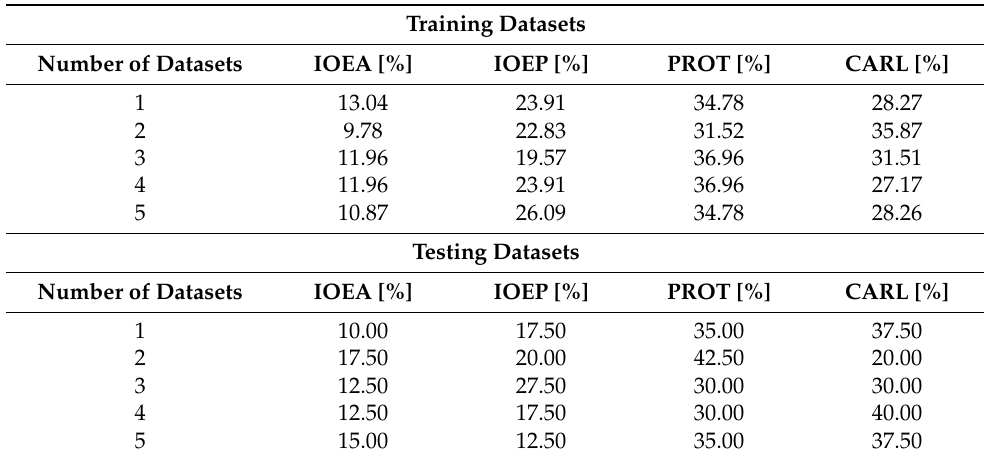
Table 2. Percentage share of each database in the appropriate training and test dataset for local descriptor and CNNs models.